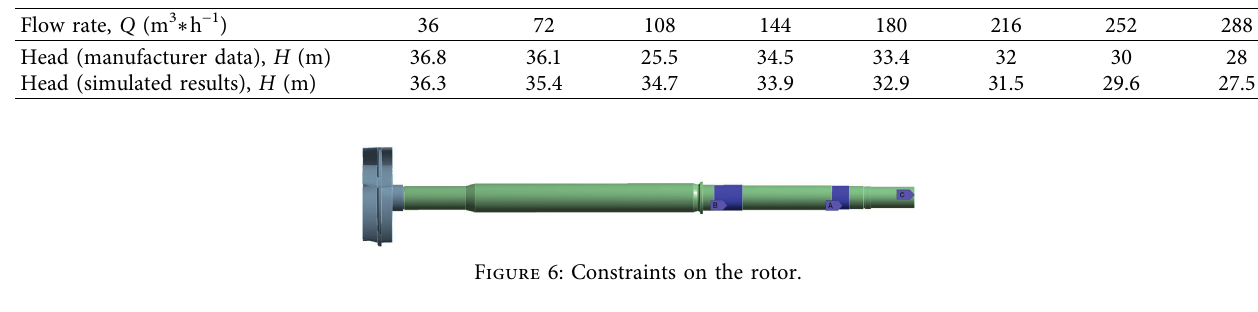
Figure 5: Predicted and measured [22] pump curves. Table 5: Measured flow characteristics.